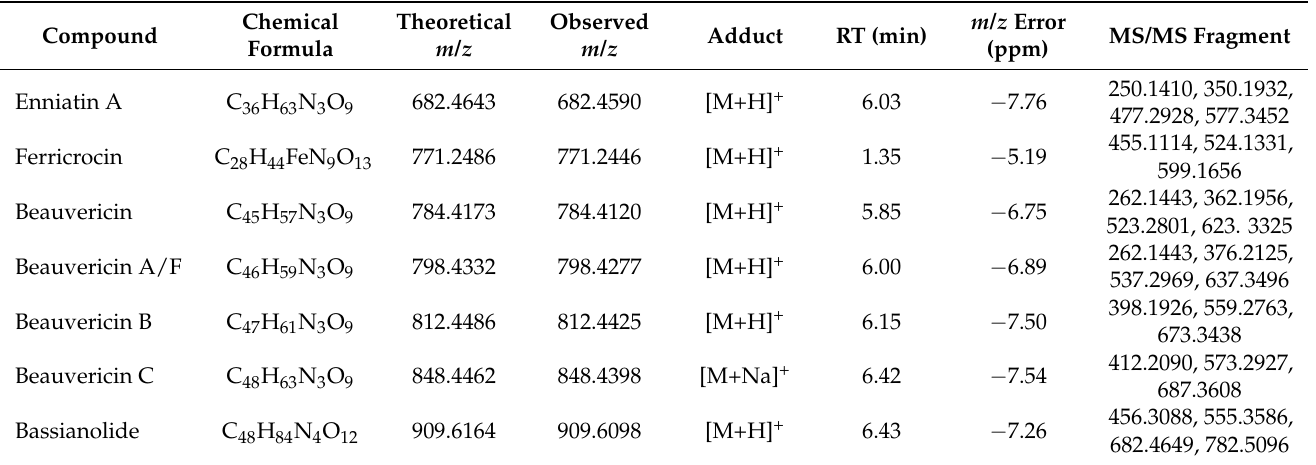
Table 1. Summary of classified insect-virulence metabolites and a siderophore identified from OE pks14 and ∆ pks14 strains in culture and in